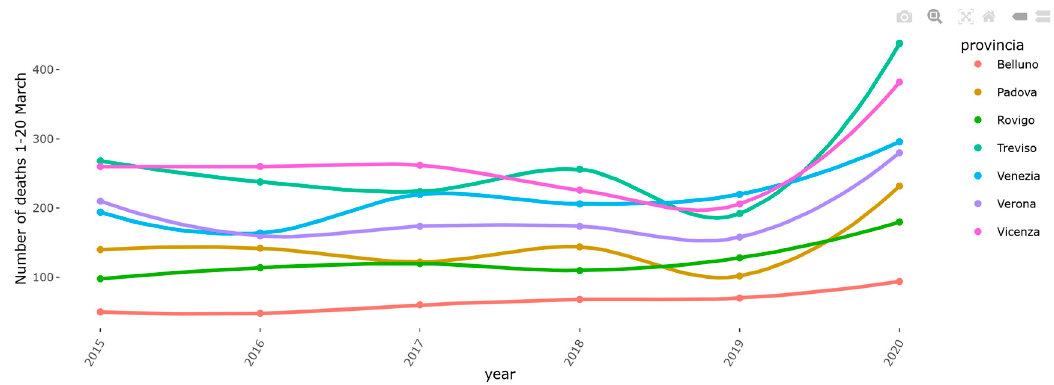
Figure 1. One example (web page screenshot) of the content in the Highlights section (namely, changes in mortality by province in the Veneto region).